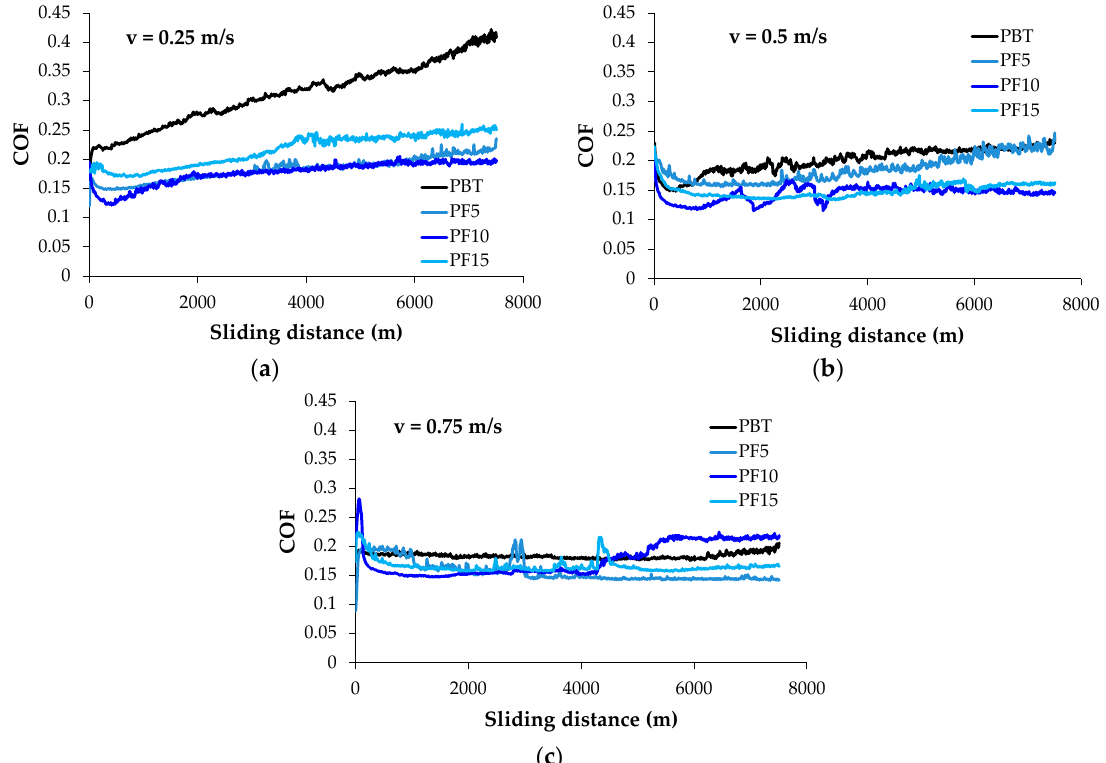
Figure 3. Evolution of friction coefficient (COF) in time for tested materials, F = 5 N, L = 7500 m: ( a ) v = 0.25 m/s; ( b ) v = 0.5 m/s; ( c ) v = 0.75 m/s.